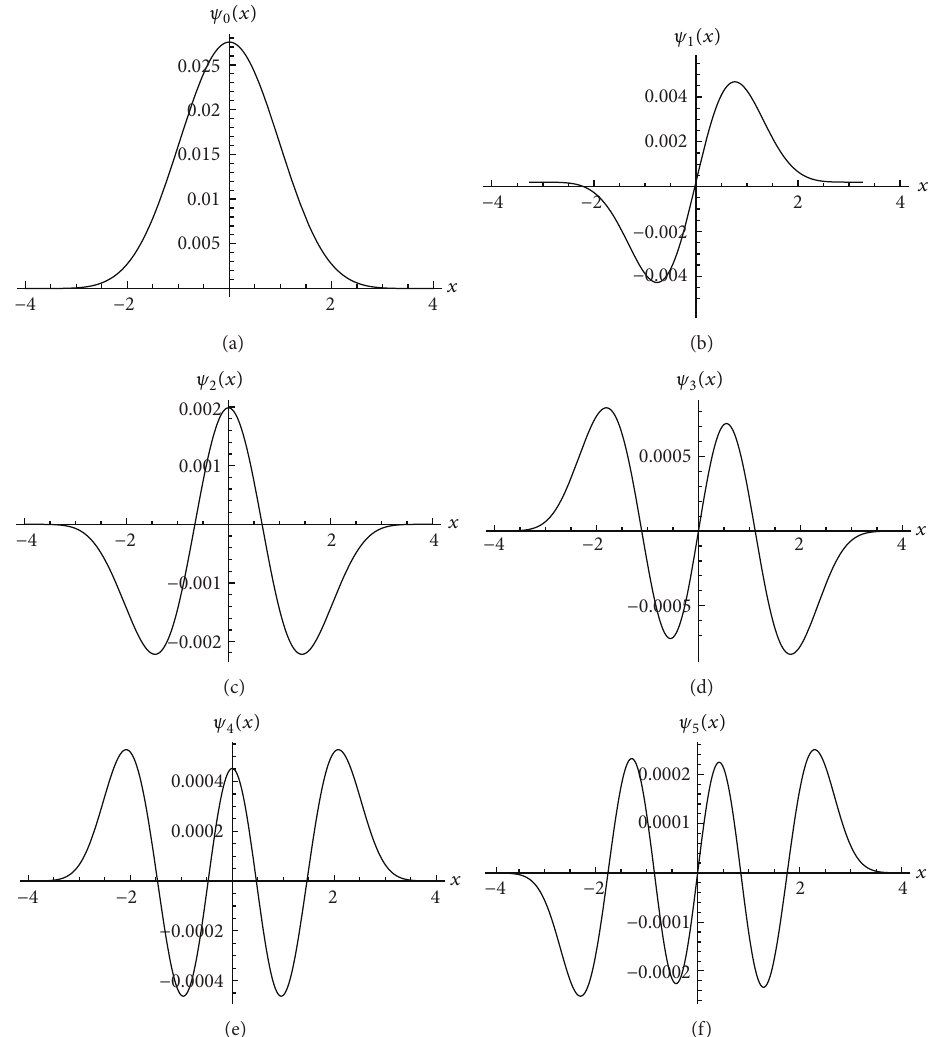
Figure 2: The first six states normalized eigenfunctions of the quartic potential given in (15) for 𝑔 = 0.1